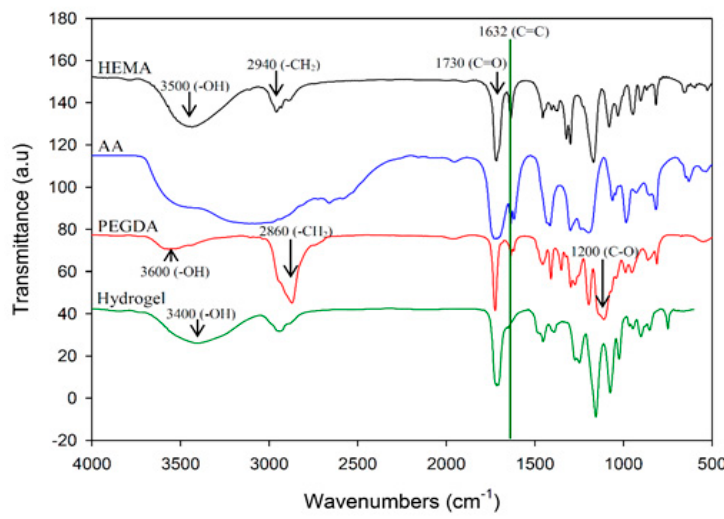
Figure 2. Fourier transform infrared spectroscopy (FTIR) analysis of HEMA, AA, PEGDA, and the